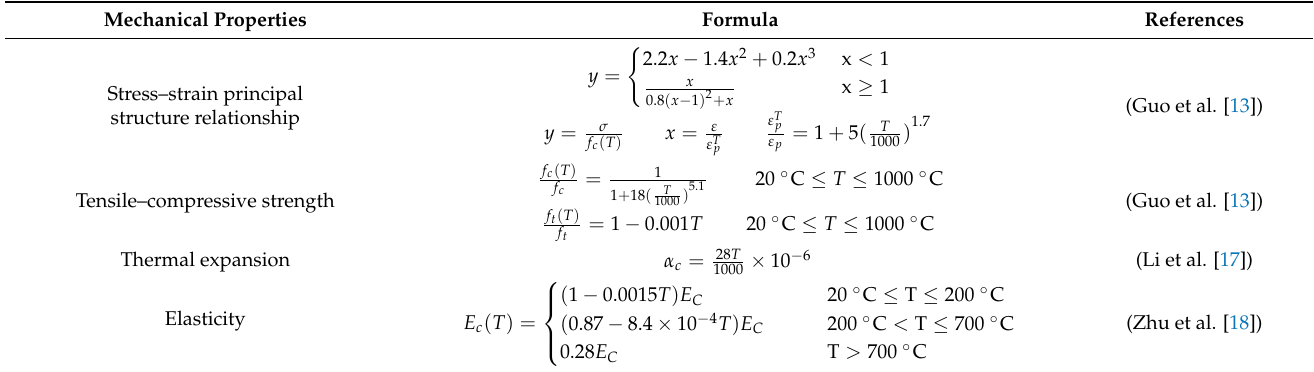
Table 3. Mechanical properties of concrete at elevated